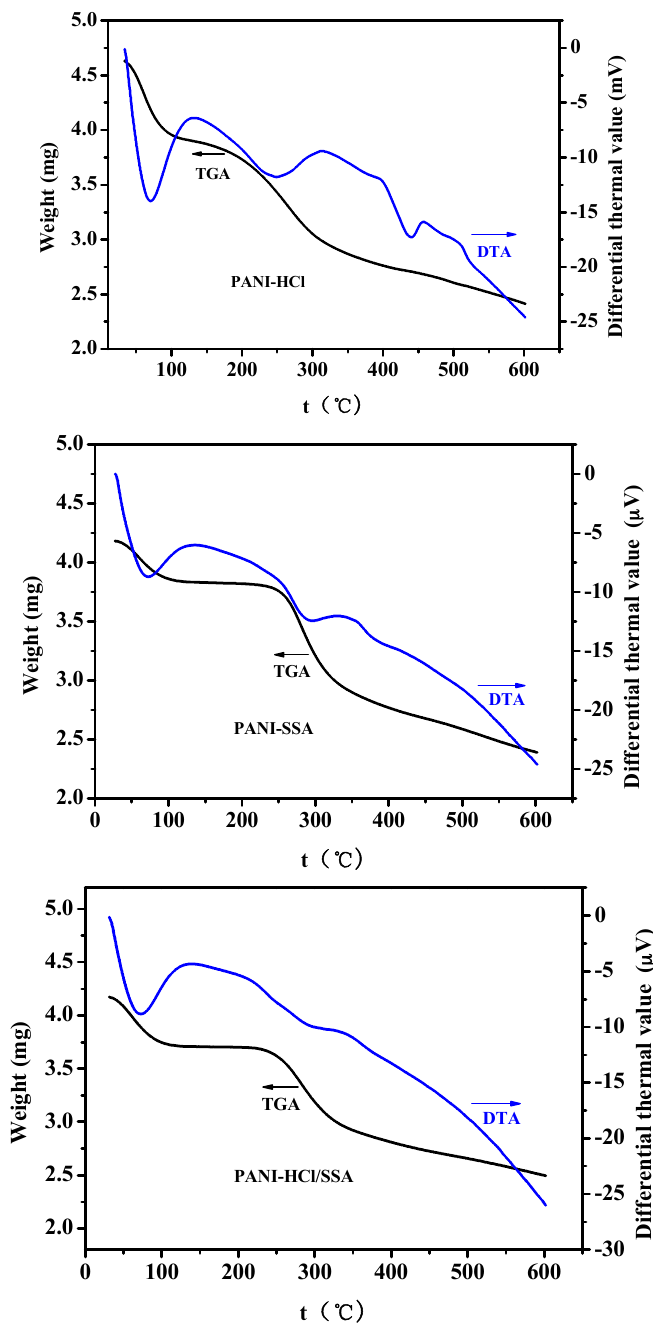
Figure 17. TGA-DTA curve of PANI-HCl ( top ), PANI-SSA ( middle ), and PANI-HCl/SSA ( bottom ). Weight loss percentage of PANI-HCl, PANI-SSA, and PANI-HCl/SSA are respectively